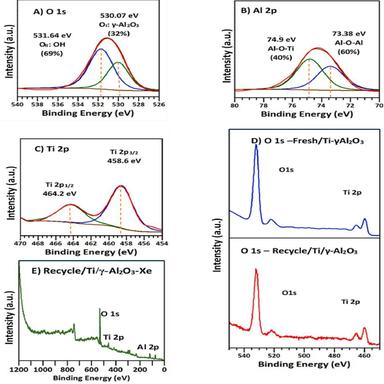
Fitted XPS spectra for A) O 1 s, B) Al 2p, C) Ti 2p for recycled Ti-γAl2O3 sample, D) Comparison of the O1s Ti 2p peaks for fresh and used Ti-γAl2O3 sample, and E) the XPS pattern of the recycled Ti-γAl2O3 sample.